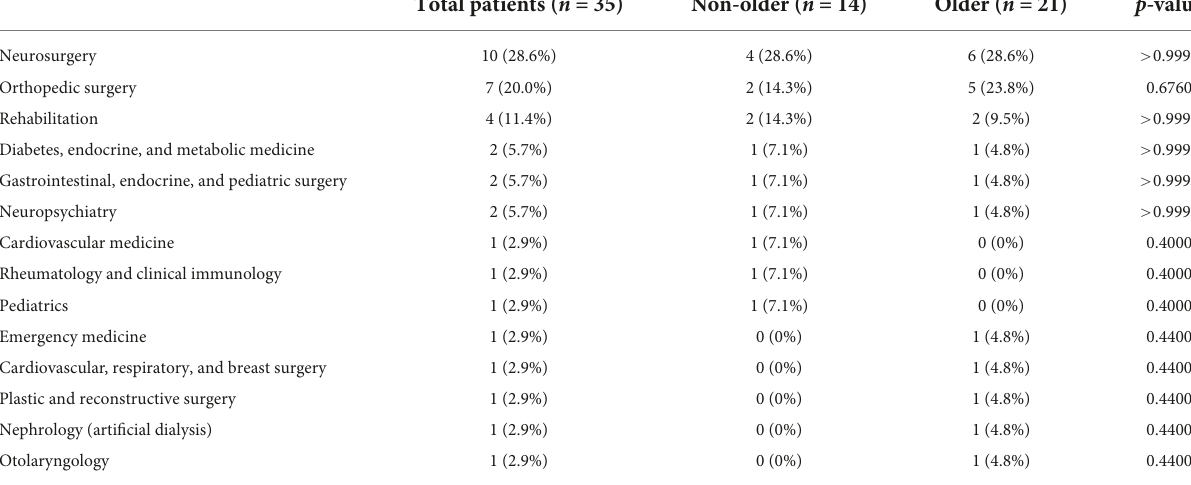
Total patients ( n =